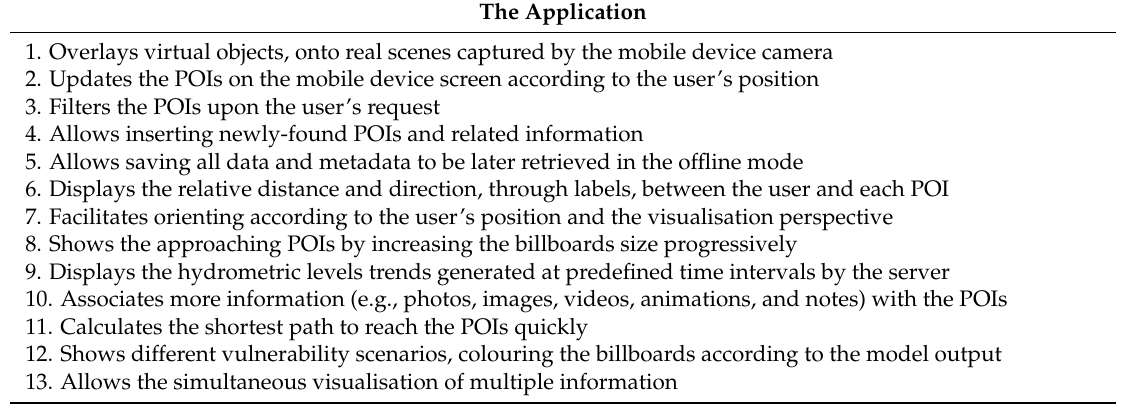
Table 1. Summary of the AR application